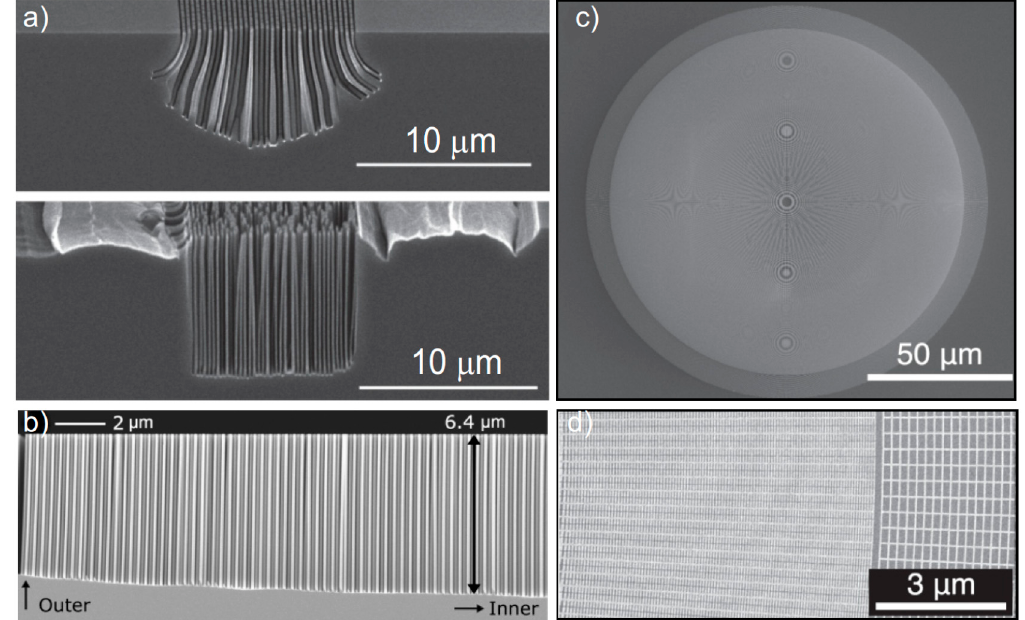
Figure 2. Schematic of preferred etching direction as a function of H 2 O 2 and HF concentration. The Si back bonds are preferentially removed along the < 100 > directions in conditions of both low H 2 O 2 and HF concentrations.